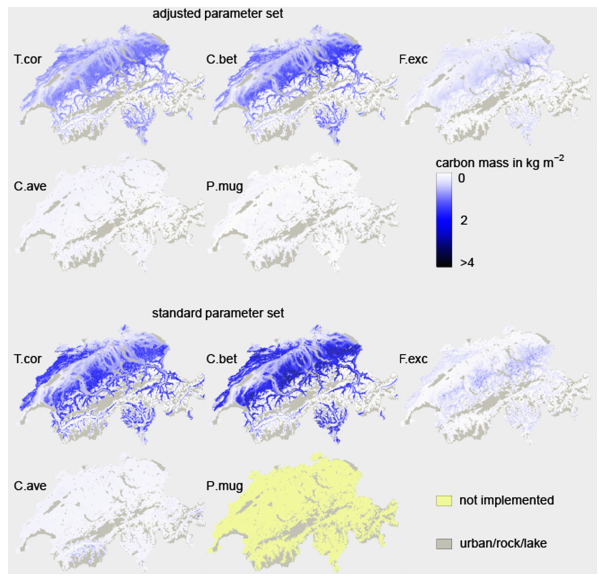
Figure D6. Carbon mass simulated with the adjusted and standard parameter set for minor species at 2100. See Fig. D5 for species abbrevi- ations. Please note that a different color gradient was used than in Fig.